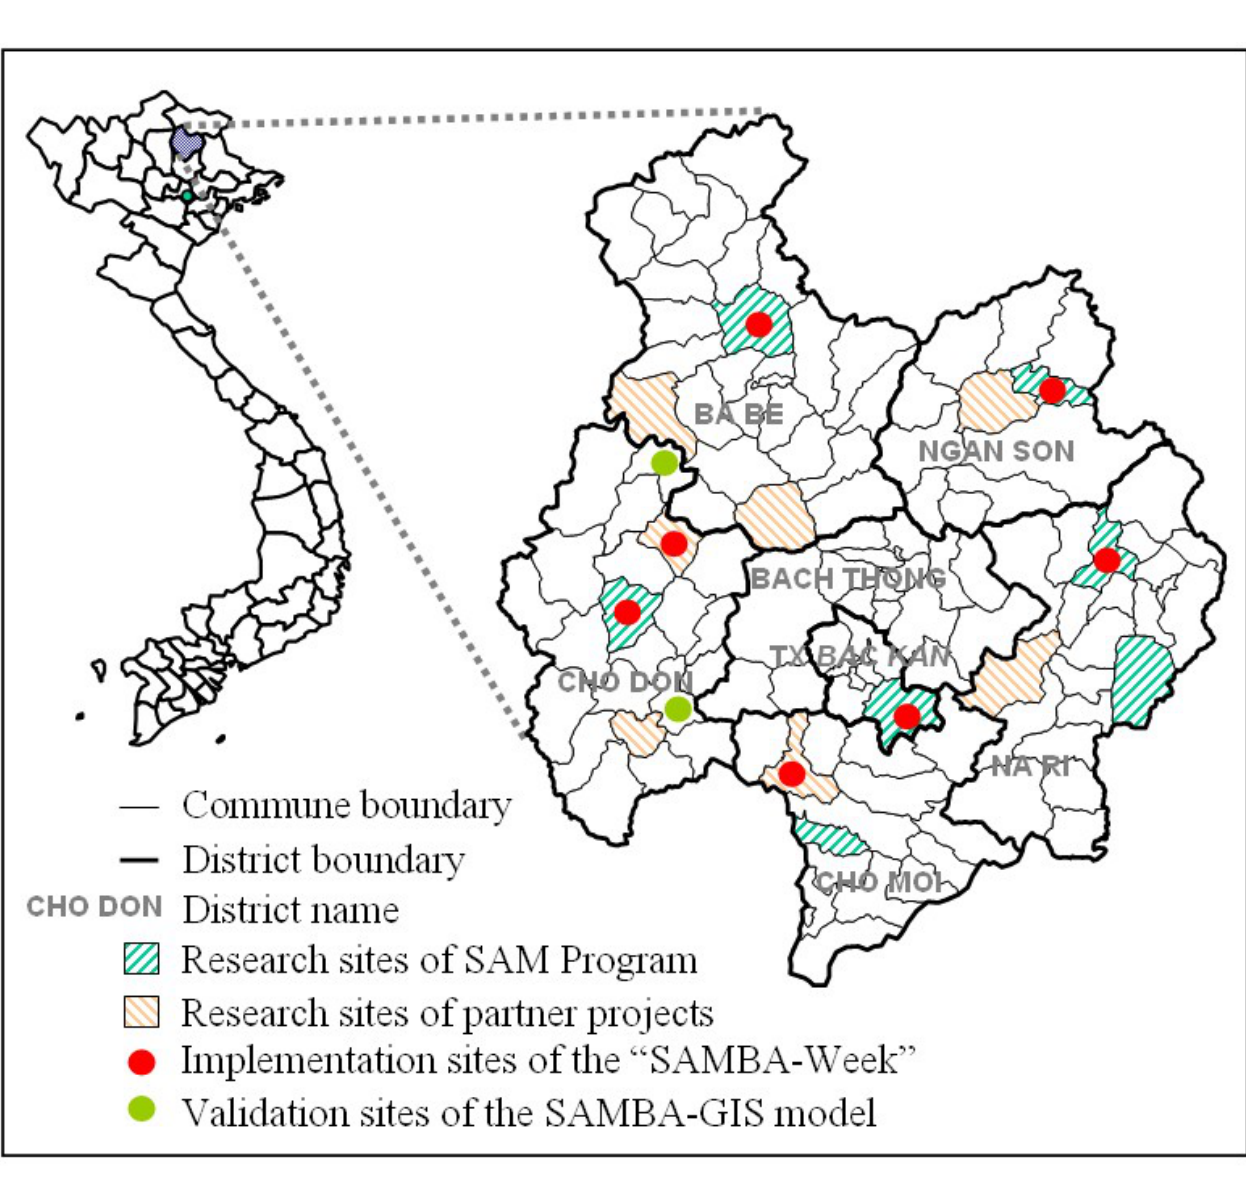
Fig. 1. Map of Bac Kan Province showing the research